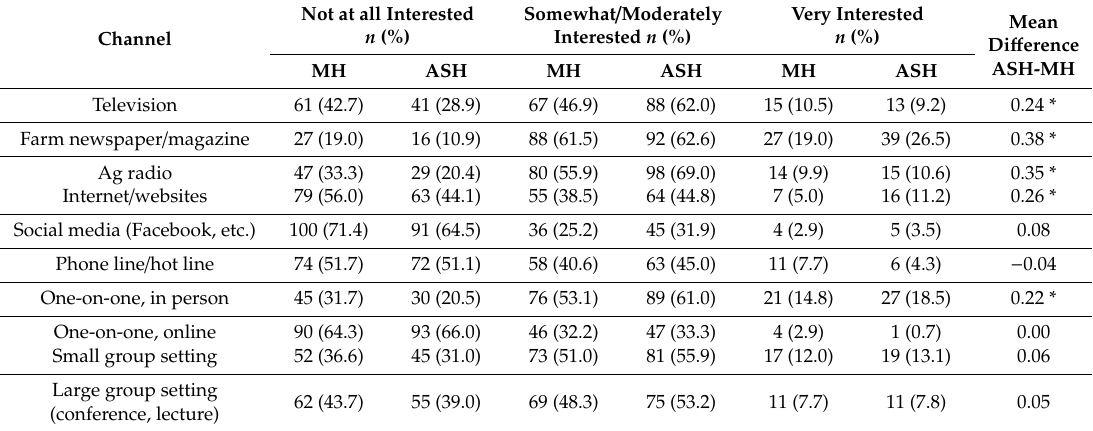
Table 3. Interest of respondents in receiving mental health (MH) and agricultural safety and health (ASH) information from various channels ( n =